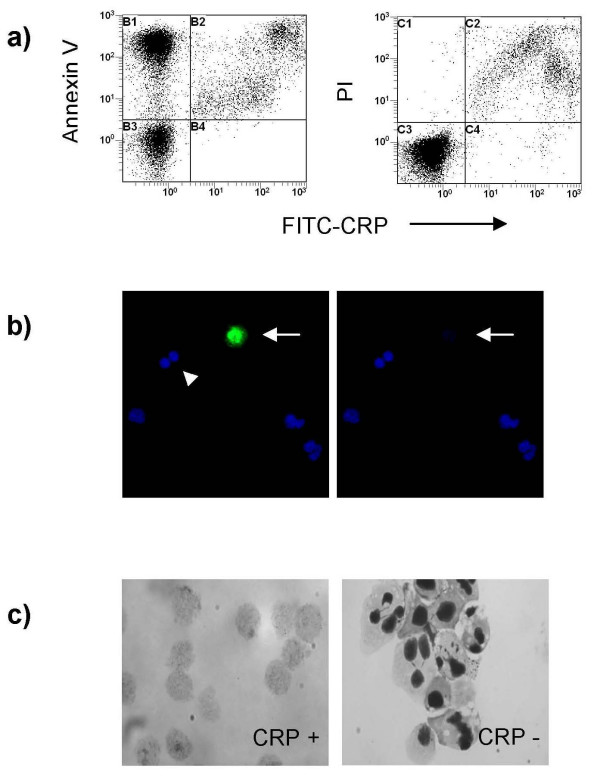
CRP binds to a subpopulation of apoptotic neutrophils. (a) Three color flow cytometry demonstrated that FITC-CRP (50 μg/ml) bound strongly to a subpopulation of apoptotic neutrophils that also stained with propidium iodide (PI). (b) Immunofluorescence microscopy of aged human neutrophils revealed strong CRP binding (green) to a late apoptotic neutrophil (arrow)(left panel). Nuclei have been stained with TO-PRO-3 (blue). The late apoptotic cell has almost no residual nuclear staining (right panel). There was no detectable binding to an early apoptotic neutrophil (arrowhead) or to non-apoptotic neutrophils. (c) Light microscopy of CRPhigh (left panel) and CRPlow (right panel) cells sorted by FACS from a population of aged neutrophils illustrates the ghost-like morphology of CRP-binding apoptotic neutrophils. The CRPlow cells comprise a mixture of non-apoptotic and early apoptotic neutrophils.